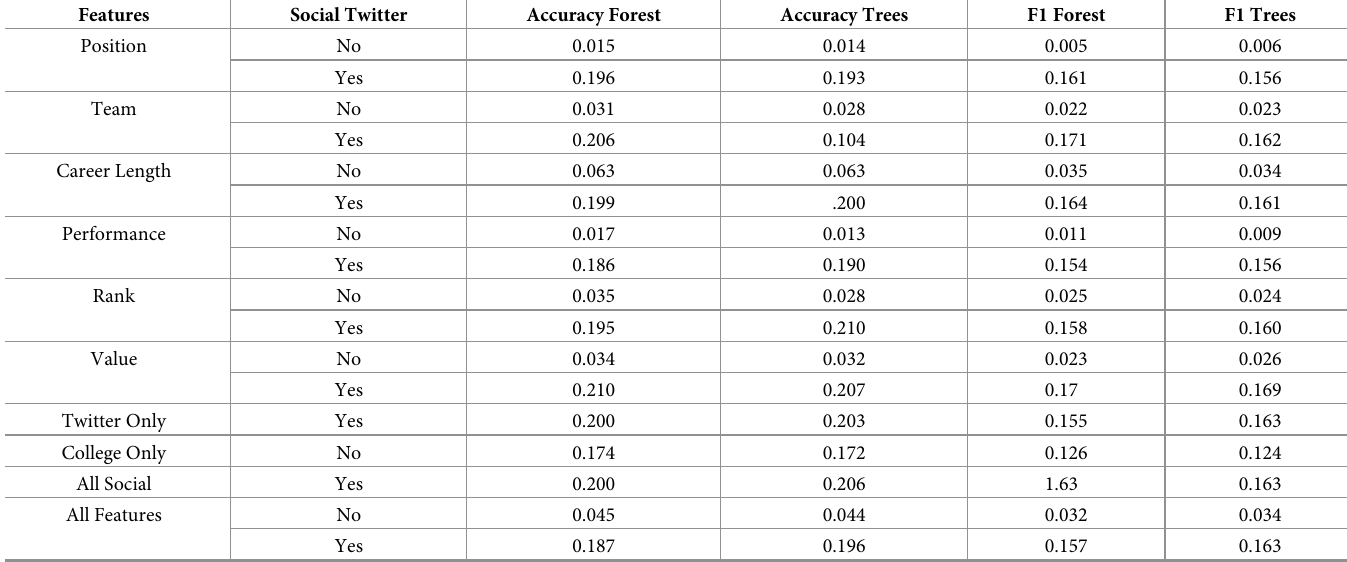
Table 7. Basketball prediction results: The predictions accuracy and F1 score is shown for team transition in the NBA during the 2020 season for players who had Twitter accounts before 2020. Each row indicates the feature(s) used. We note that a “yes” in the social column implies Twitter data was used. The “All Social” row includes both Twitter and College data.